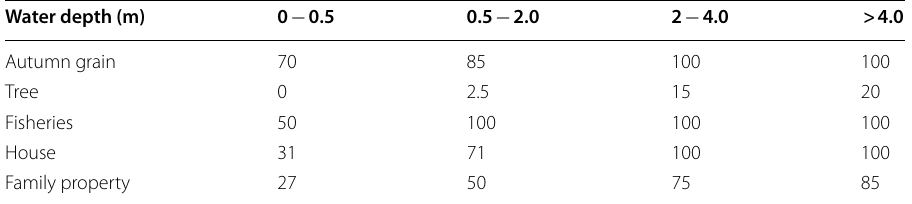
Table 4 Water depth of different disaster-bearing bodies — direct economic loss rate η relationship Water depth (m) 0 −